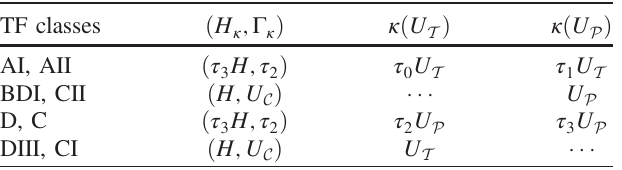
TABLE XIX. The mapped Hamiltonian (B5) and the repre- sentation the antiunitary (anti)symmetries T and P under application of the dimension-raising isomorphism κ for the real tenfold-way